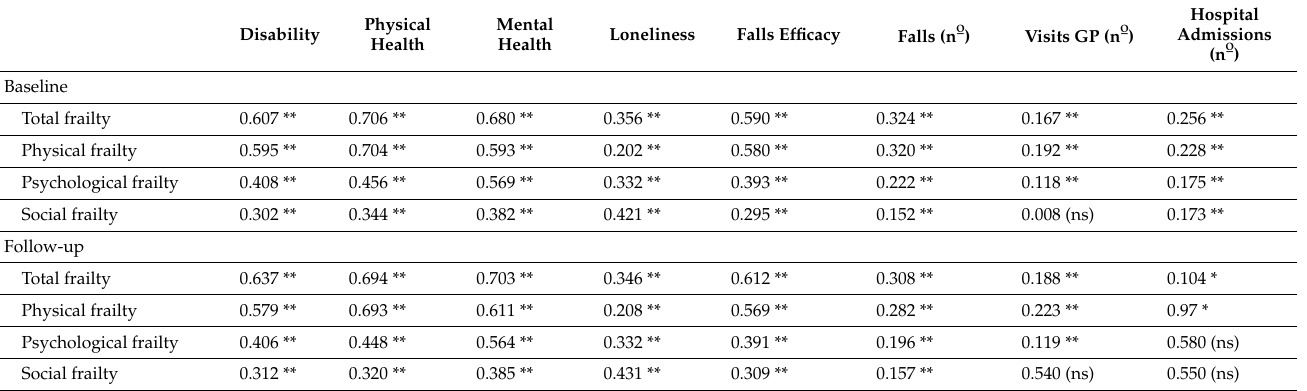
Table 2. Correlations between frailty and adverse outcomes.